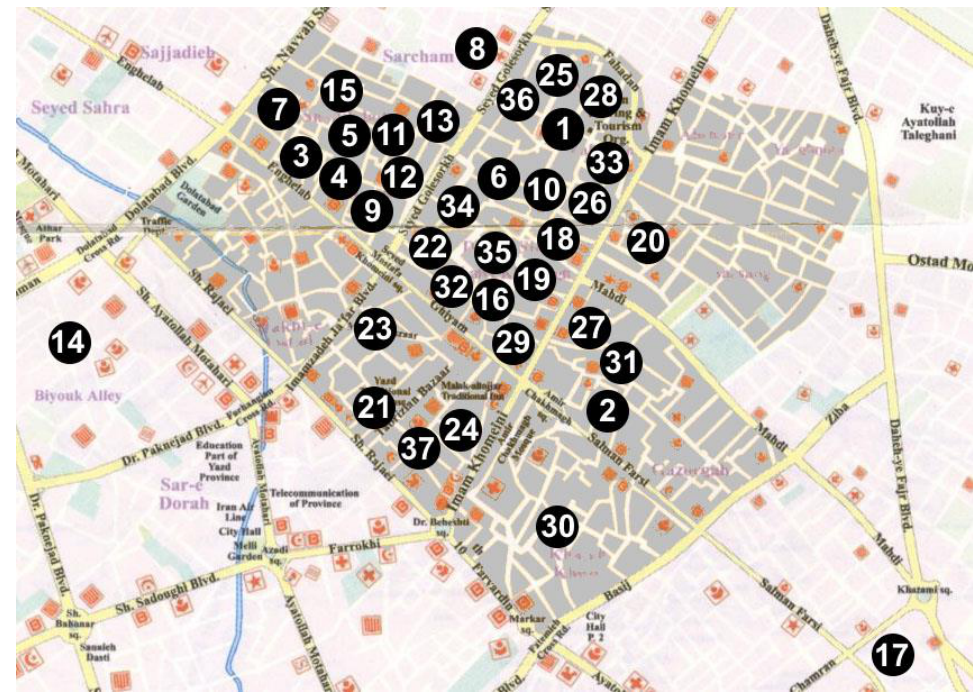
Figure 3. Plan of the historic city of Yazd (Iran), showing the location of the 37 cases measured and compared in this paper (see Table 1 for key).